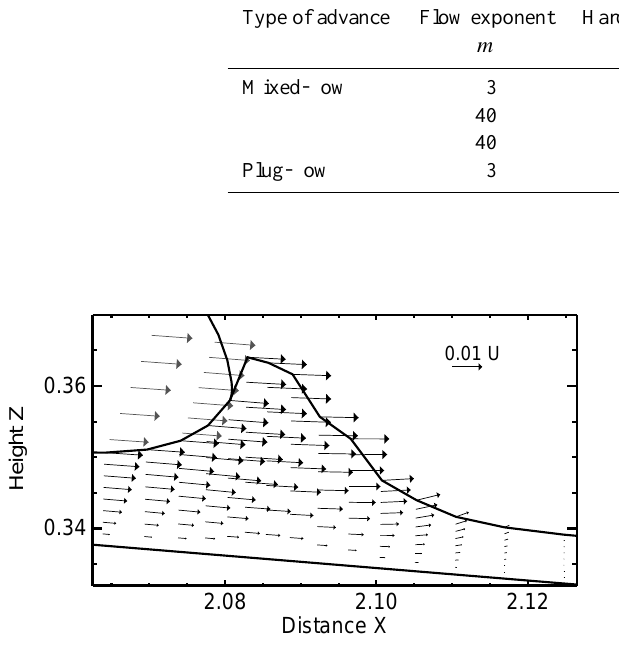
Fig. 9. Experiment B: Relatively soft and moderately non-linear till ( m =3 , B =0 . 35 ): Velocity vectors of the sediment bulge are shown at the dimensionless time T =15 . Velocity vectors are mostly parallel to the bed. Sediment uplift takes place at the downfacing side of the bulge.